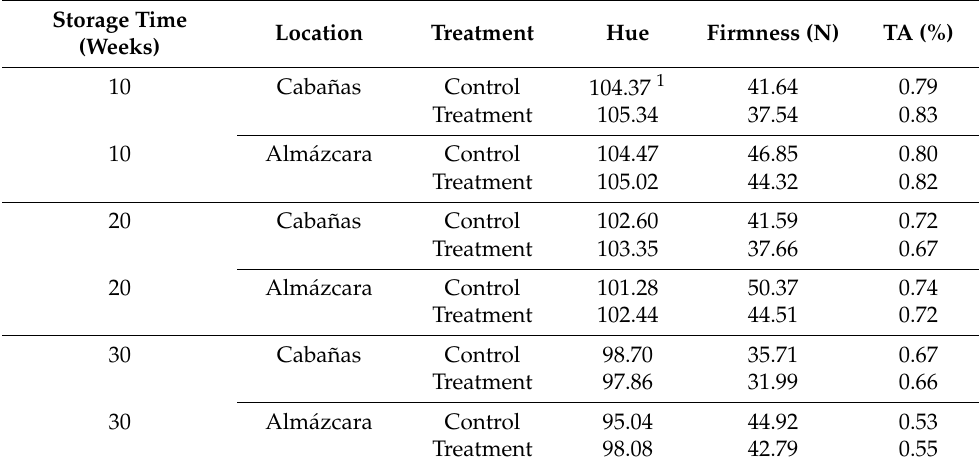
Table 5. Effect of pruning on instrumental quality attributes of apple cv. ‘Reinette du Canada’ during